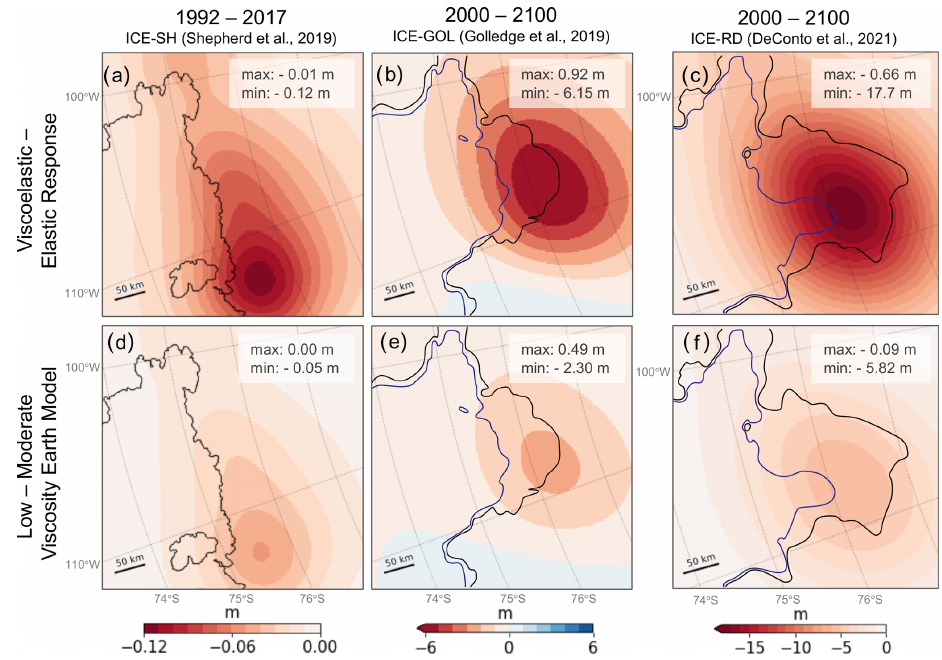
Figure 6. Influence of incorporating viscous behaviour and uncertainty in viscoelastic Earth structure on sea-level predictions. Panels (a–c) show the difference in sea-level change predicted from simulations adopting the 3-D viscoelastic Earth model EM1_L and an elastic Earth model. Panels (d–f) show the difference in sea-level change predicted from simulations adopting two different 3-D viscoelastic Earth models, EM1_L and EM1_M. Note the difference in scale. Time frames and ice models are as indicated at the top of the columns. In each panel, the black and blue lines indicate final and initial grounding lines, respectively, for each simulation and are annotated with the maximum and minimum data value within the panel. All simulations adopt a 1.9km grid